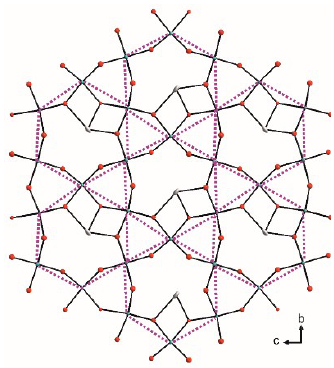
Figure 4. Pseudohexagonal arrangement of the Mo* / Fe* atoms in the (011) plane. (Mo* / Fe*) = Light blue, Sb = Grey, O = Red.